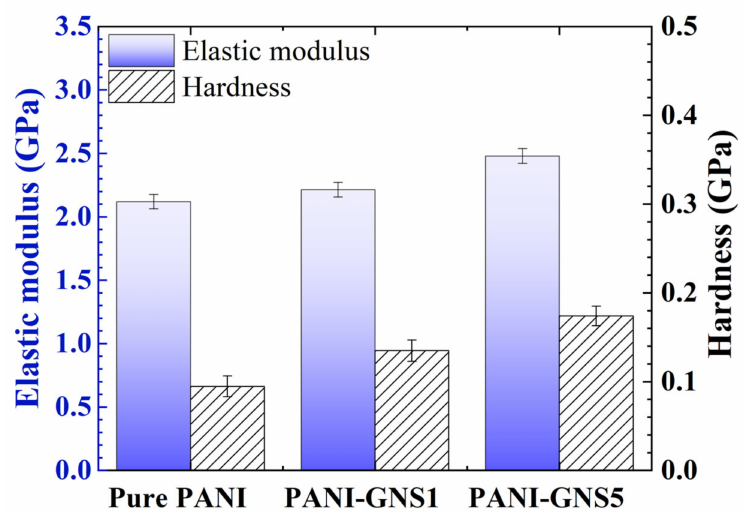
Figure 4. Young modulus and hardness of flexible and free-standing PANI/CSA membranes at various GNS